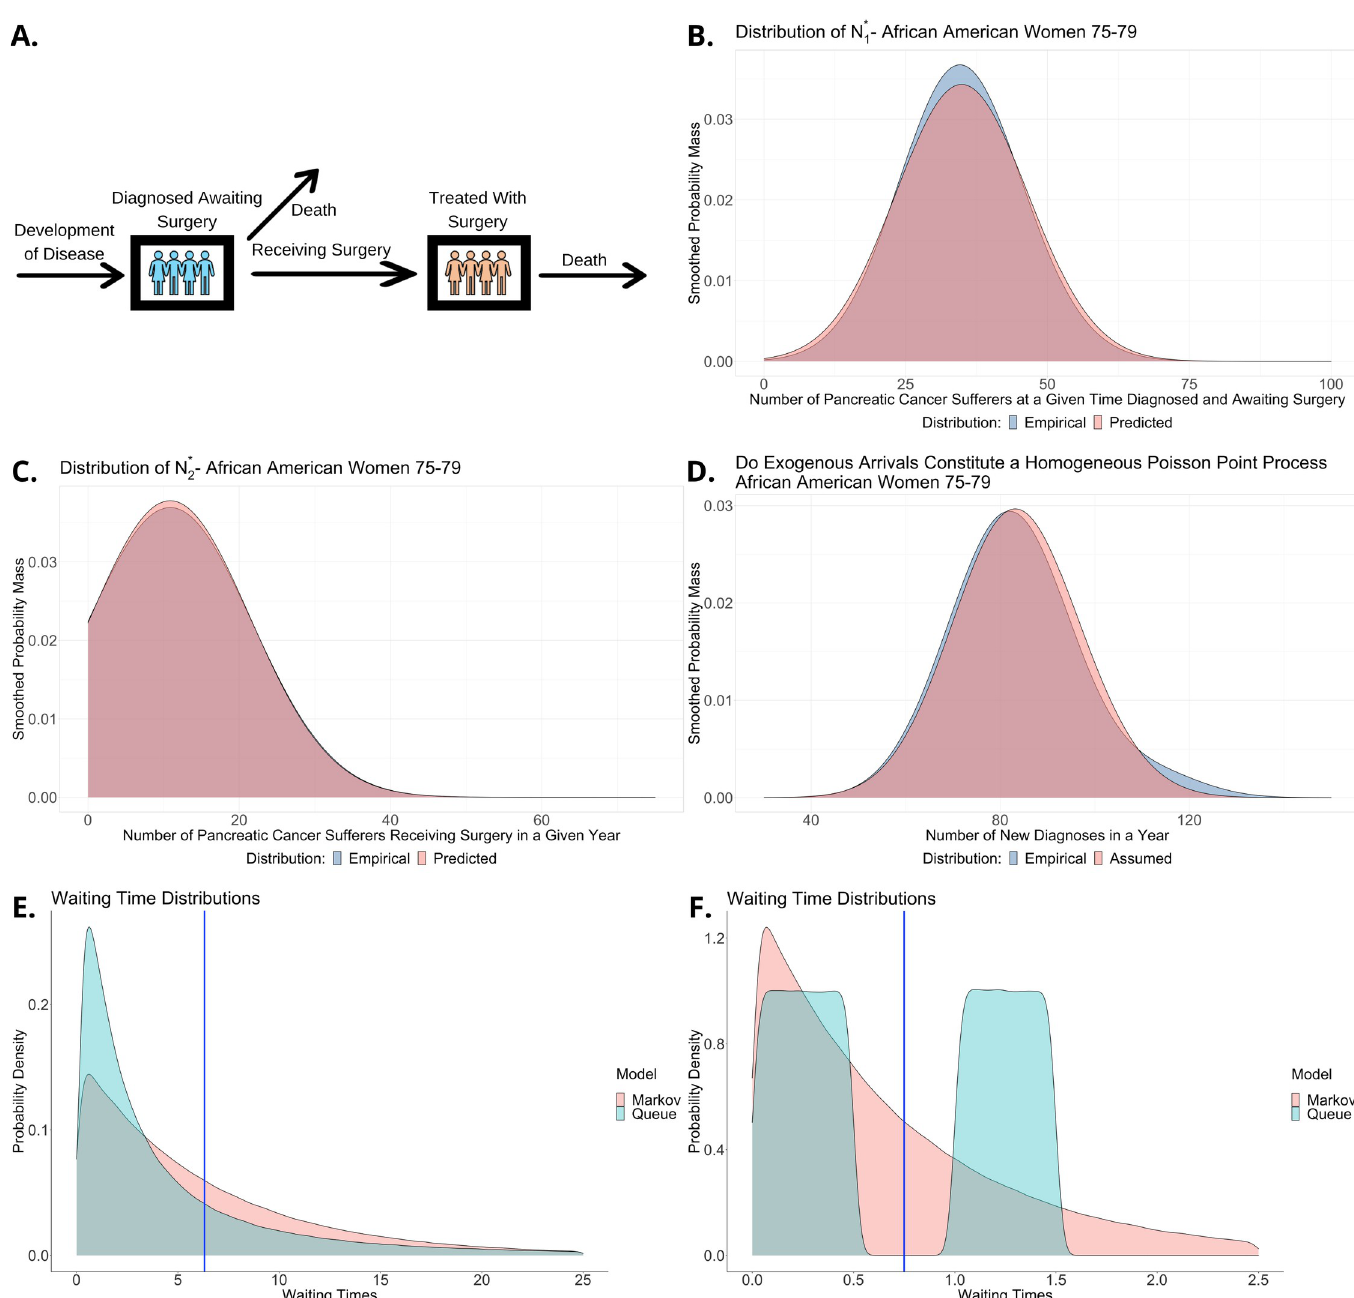
Fig 3. Distributional descriptions of the modeling framework. (A) Schematic queuing model of pancreatic cancer diagnosis and surgery. (B) Testing the distributional predictions of the BCMP theorem for the number of diagnosed pancreatic cancer cases among African American women aged 75–79 awaiting surgery as a particular example. We compare the predicted distribution of N � from the model and the empirical distribution of this quantity from the incidence data. Probability mass functions 1 are kernel smoothed to ease visualization. (C) Testing distributional model predictions for the number of African American women aged 75–79 with pancreatic cancer each year who receive surgery, N � , against the empirical distribution from the data. (D) Testing whether pancreatic cancer diagnoses of African American women aged 2 75–79 follow the Markovian assumption for exogenous arrivals required by the BCMP theorem. (E) A model comparison of how waiting time distributions are approximated. A deterministic model uses the average only, Markov models approximate by the best fitting exponential distribution, whereas simulations and queuing models can use the ‘true’ distribution–in this case a lognormal distribution. (F) Comparing how a mixture waiting time distribution is modeled.